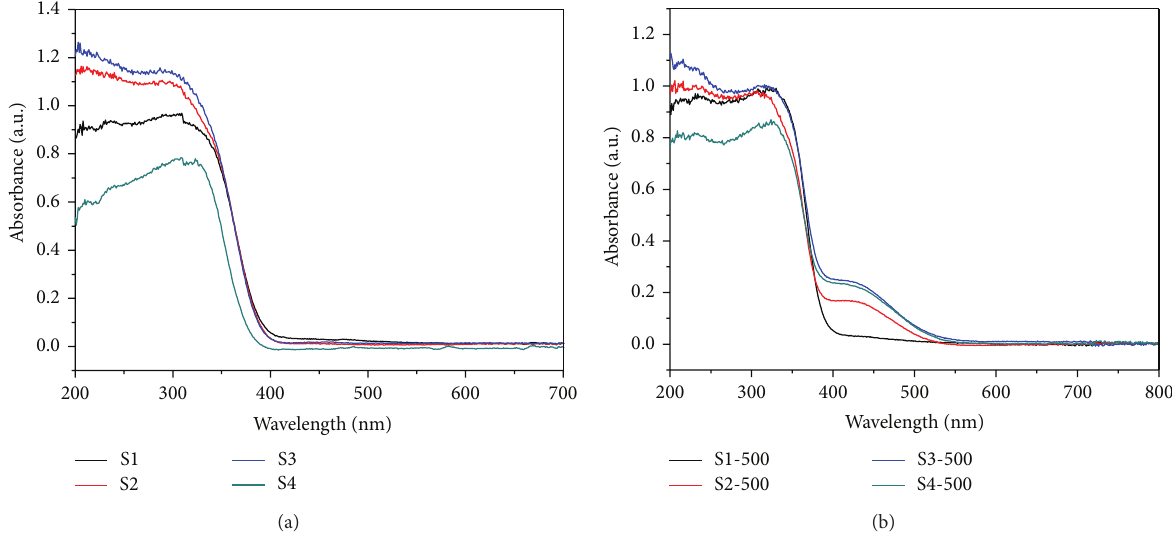
Figure 4: UV-Vis diffuse reflectance spectra of all samples ((a) the uncalcined samples, (b) the calcined